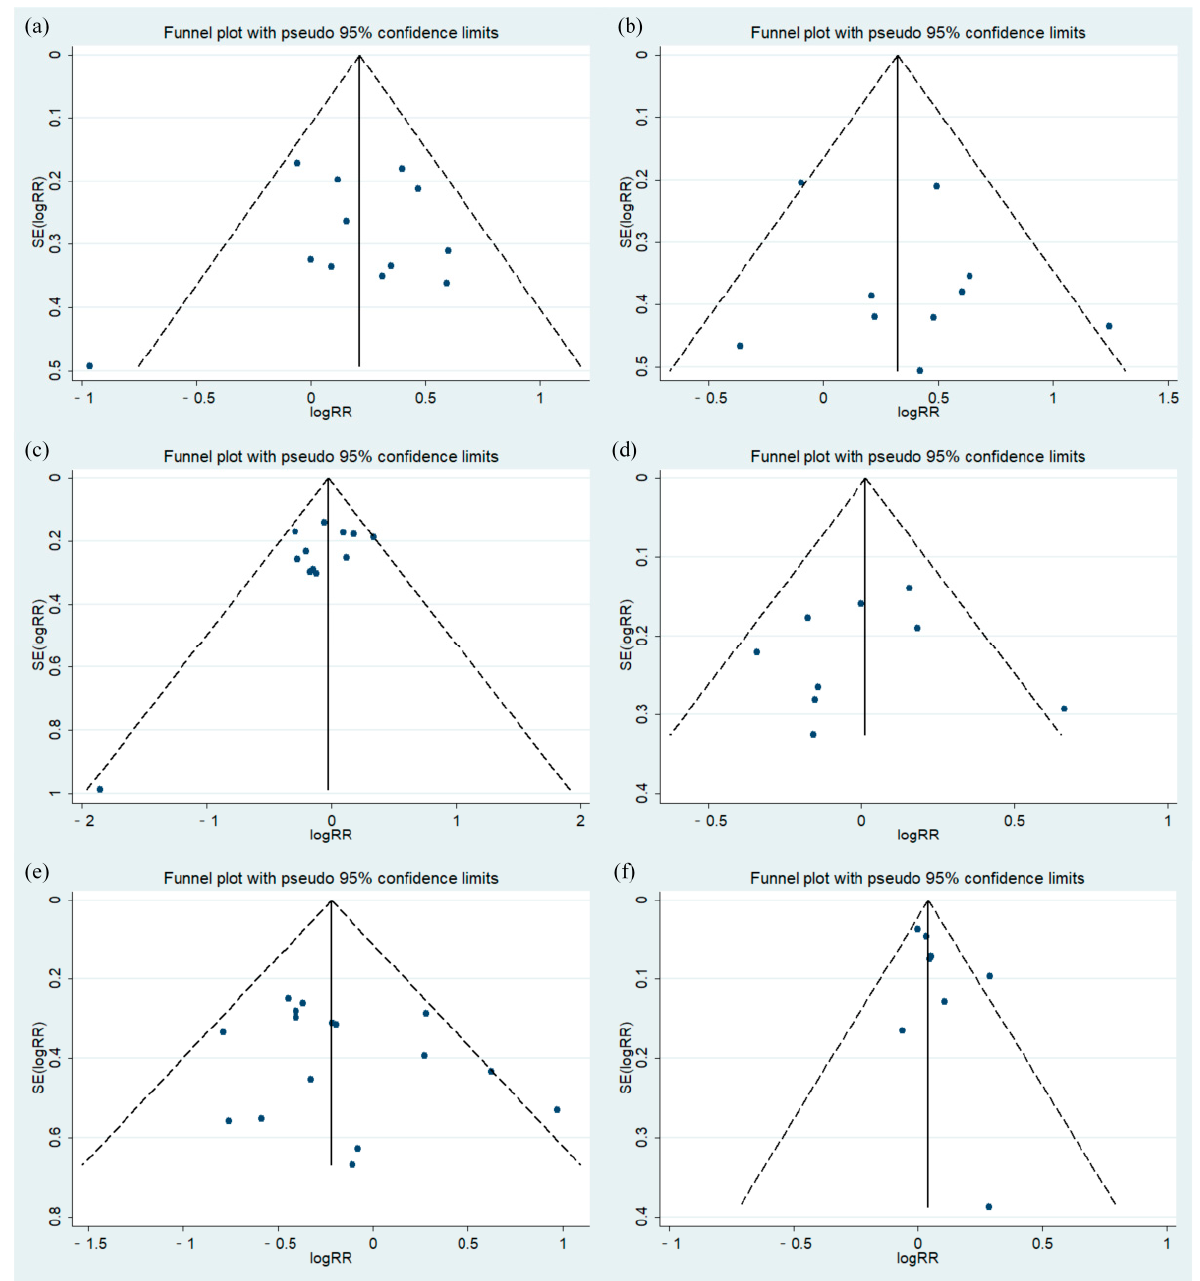
Figure 5. Funnel plots for publication bias. ( a ) 3-year OS in dCRT; ( b ) 3-year PFS in dCRT; ( c ) 3-year OS in nCRT; ( d ) 3-year PFS in nCRT; ( e ) pCR; ( f ) R0 resection.